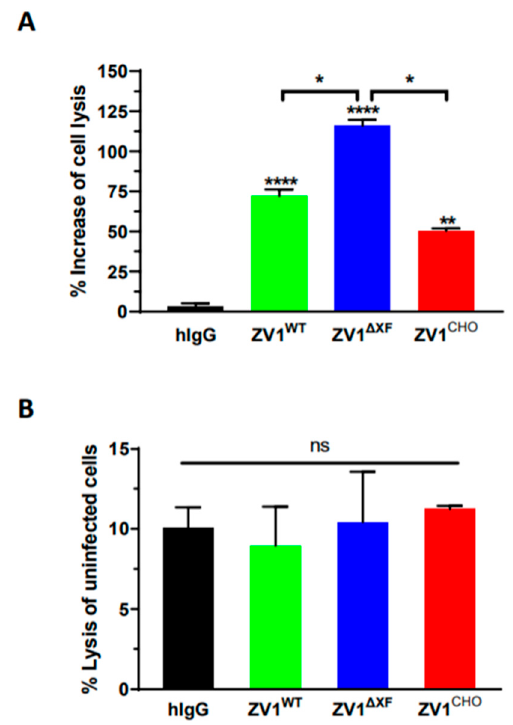
Figure 4. Antibody-dependent cellular cytotoxicity (ADCC) of ZV1 glycovariants. ADCC assay was performed by incubation of NK cells with ZIKV-infected Vero cells ( A ) or uninfected Vero cells ( B ) at the E:T ratio of 5:1 in the presence of indicated mAb glycovariants or a human IgG isotype negative control (hIgG). The % of mAb-NK cell-mediated Vero cell lysis (ADCC target cell killing) and % increase of ZV1 ADCC compared to the negative control hIgG or between ZV1 glycovariants were calculated. ****, **, * and ns indicate p values < 0.0001, =0.0021, <0.05, and >0.05, respectively.